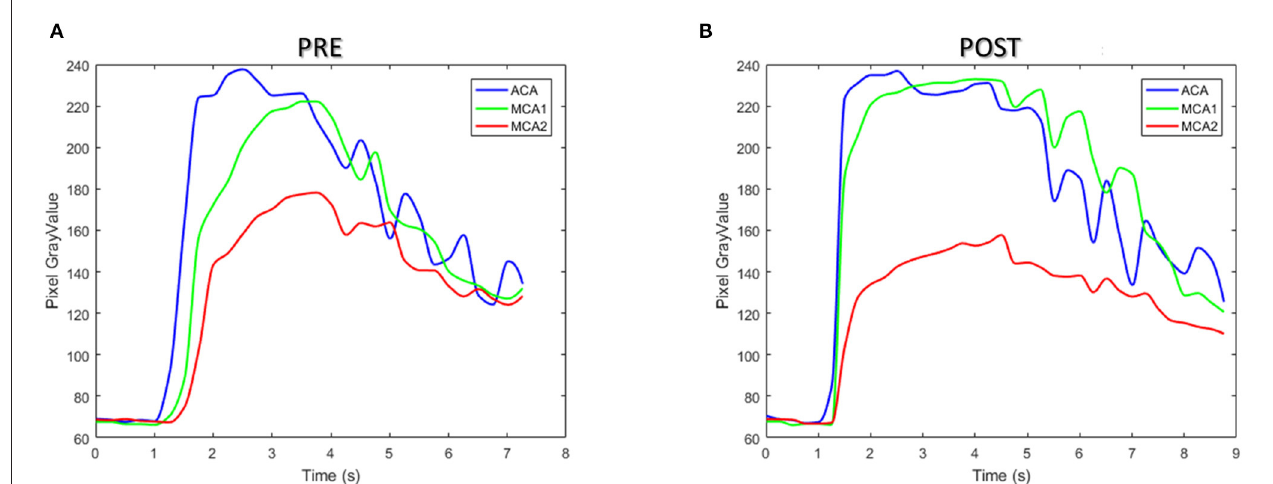
FIGURE 10 | The time–density curve of the patient between pre- (A) and post-interventional (B) surgery.